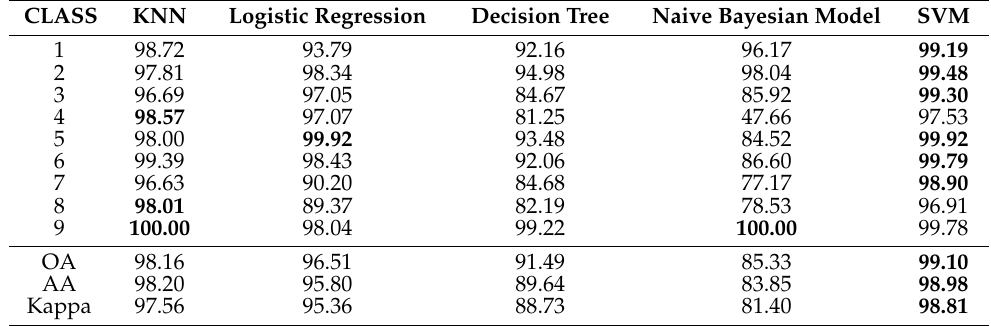
Table 3. Classification accuracy (%) for the Kennedy Space Center dataset via different classifiers we used in this paper. CLASS KNN Logistic Regression Decision Tree Naive Bayesian Model SVM 1 93.89